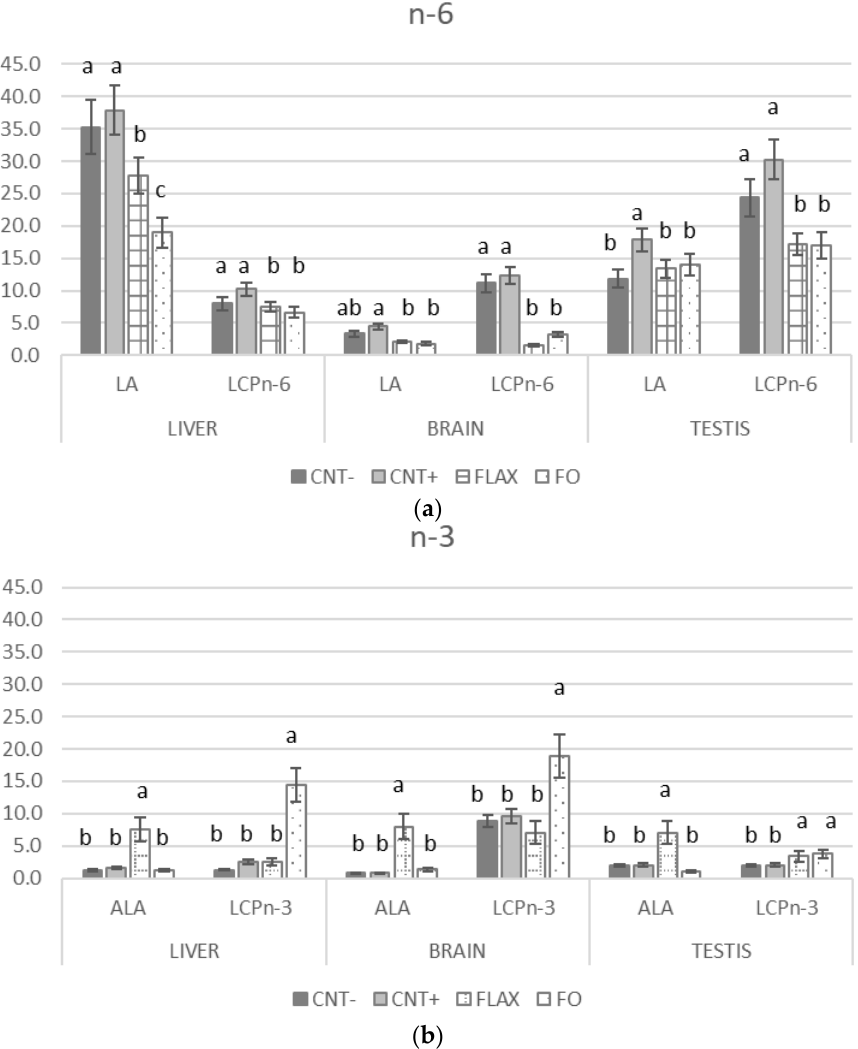
Figure 5. The effect of experimental diets on the long-chain fatty acid (LCP) content of rabbit liver, brain, and testis (presented as % of total fatty acids (FAs)) for the ( a ) n-6 and ( b ) n-3 polyunsaturated fatty acid (PUFA) series. The bars represent least squares means + 95% upper and lower limits. a, b indicate a significant difference between dietary groups ( p < 0.05, Bonferroni post hoc test).